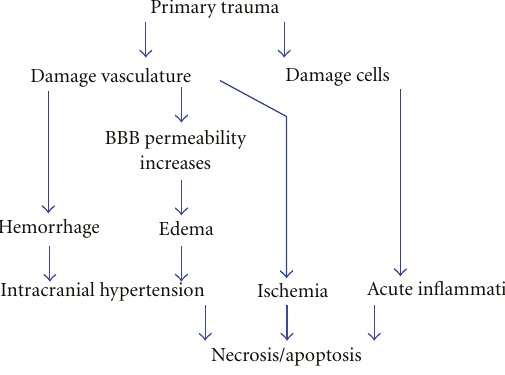
Figure 1: Sequential events of primary injury in TBI. Initial impact is usually by directing trauma to the head either open or closed head injury. This trauma will cause mechanical damage to neurons, axons, glia, and blood vessels by shearing, tearing, or stretching. Blood vessel ruptures cause hemorrhage. Even in unruptured